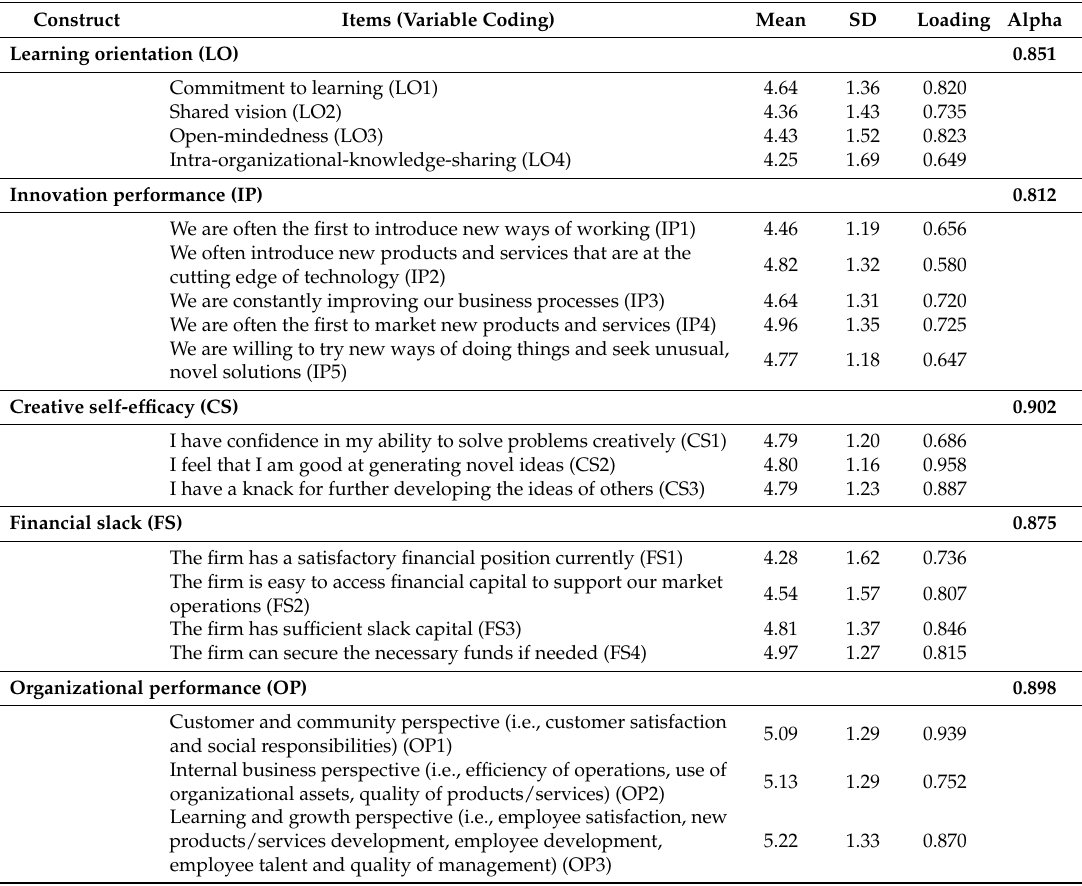
Table 2. Data description and reliability